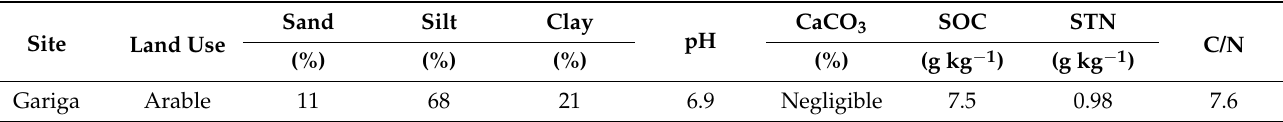
Table 1. Main physicochemical characteristics of the soil used for incubation.